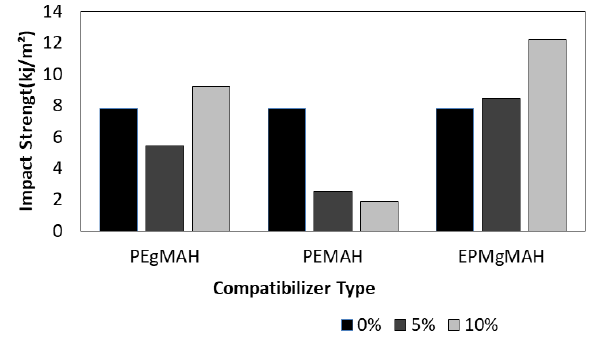
Figure 4: Impact strength values of prepared r-LDPE/TPS based blends.